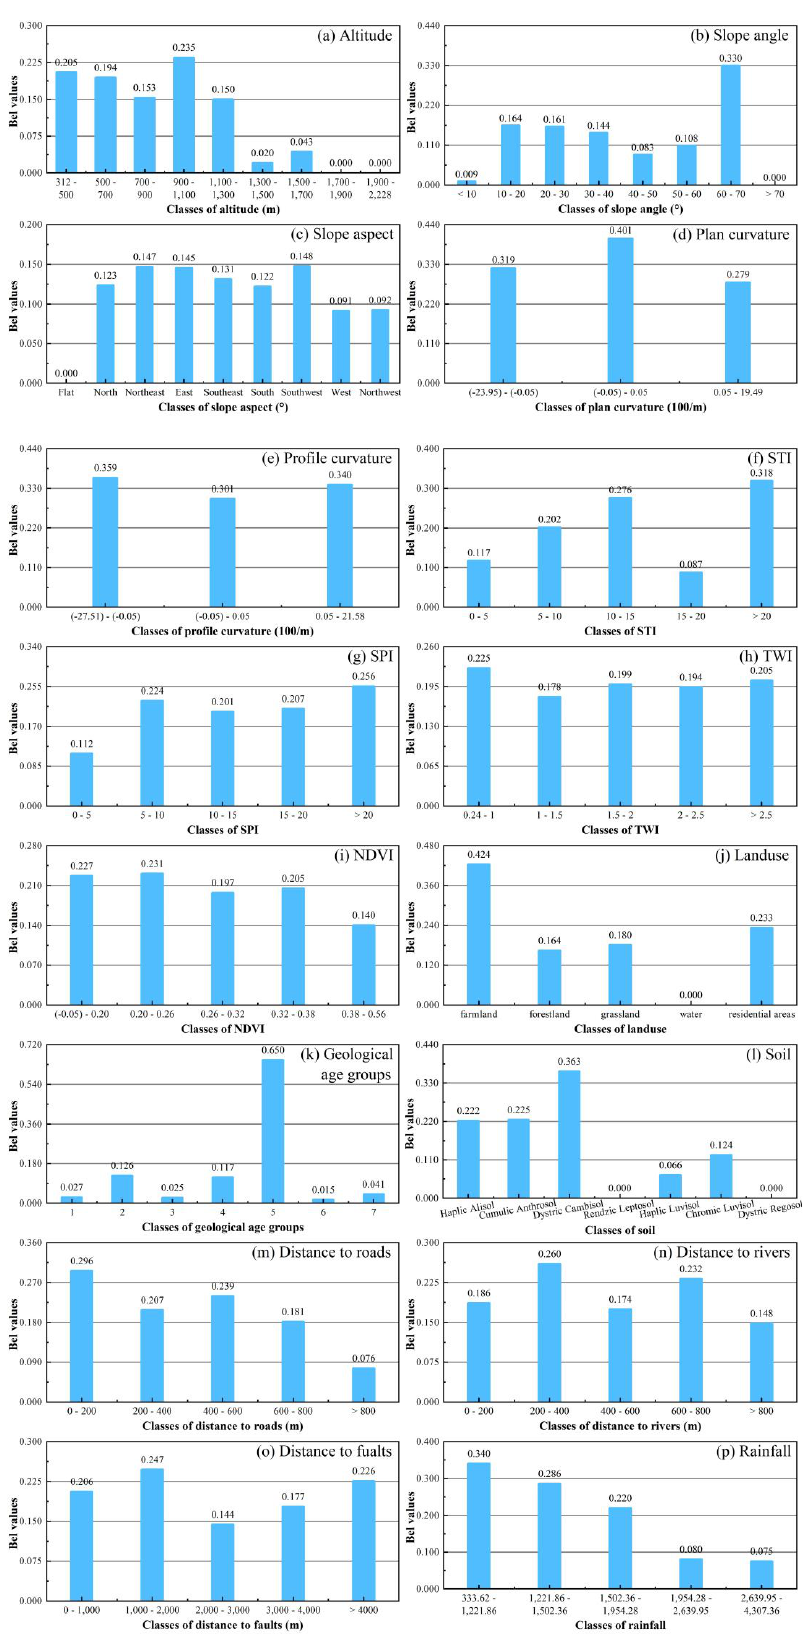
Figure 6. Relationship between landslides and the landslide conditioning factors of ( a ) altitude, ( b ) slope angle, ( c ) slope aspect, ( d ) plan curvature, ( e ) pProfile curvature, ( f ) STI, ( g ) SPI, ( h ) TWI, ( i ) NDVI, ( j ) land use, ( k ) geological age groups, ( l ) soil, ( m ) distance to roads, ( n ) distance to rivers, ( o ) distance to faults, ( p ) rainfall.